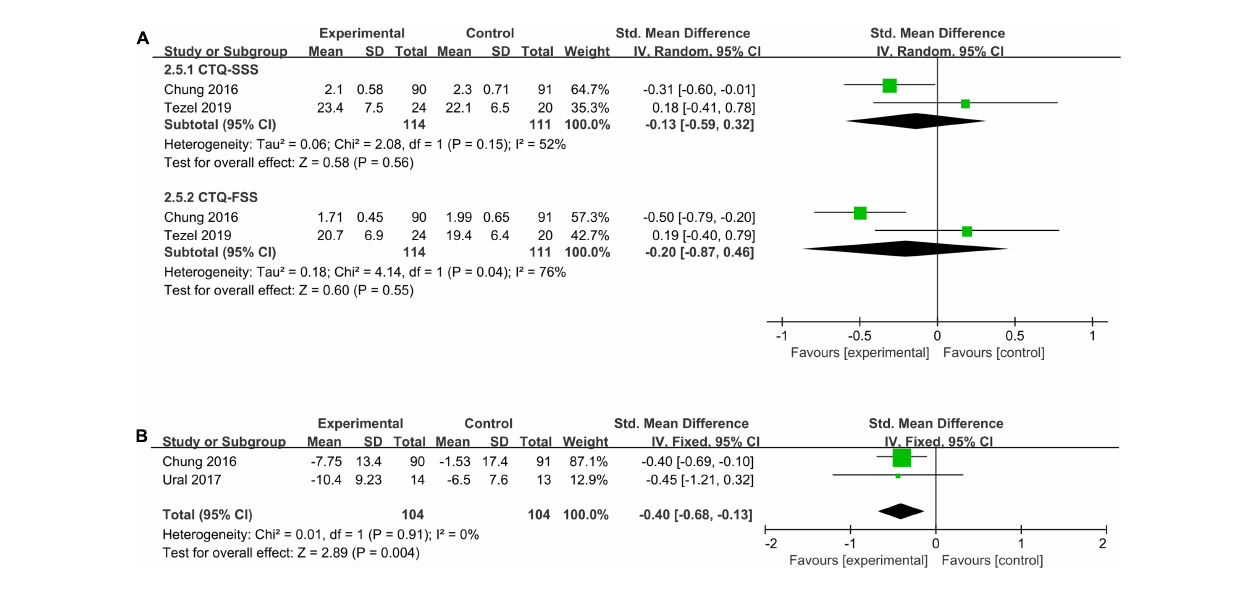
FIGURE5 A meta-analysis of symptom severity and functional status of acupuncture plus night splints vs. night splints. (A) CTQ-SSS and CTQ-FSS; (B) change of DASH.